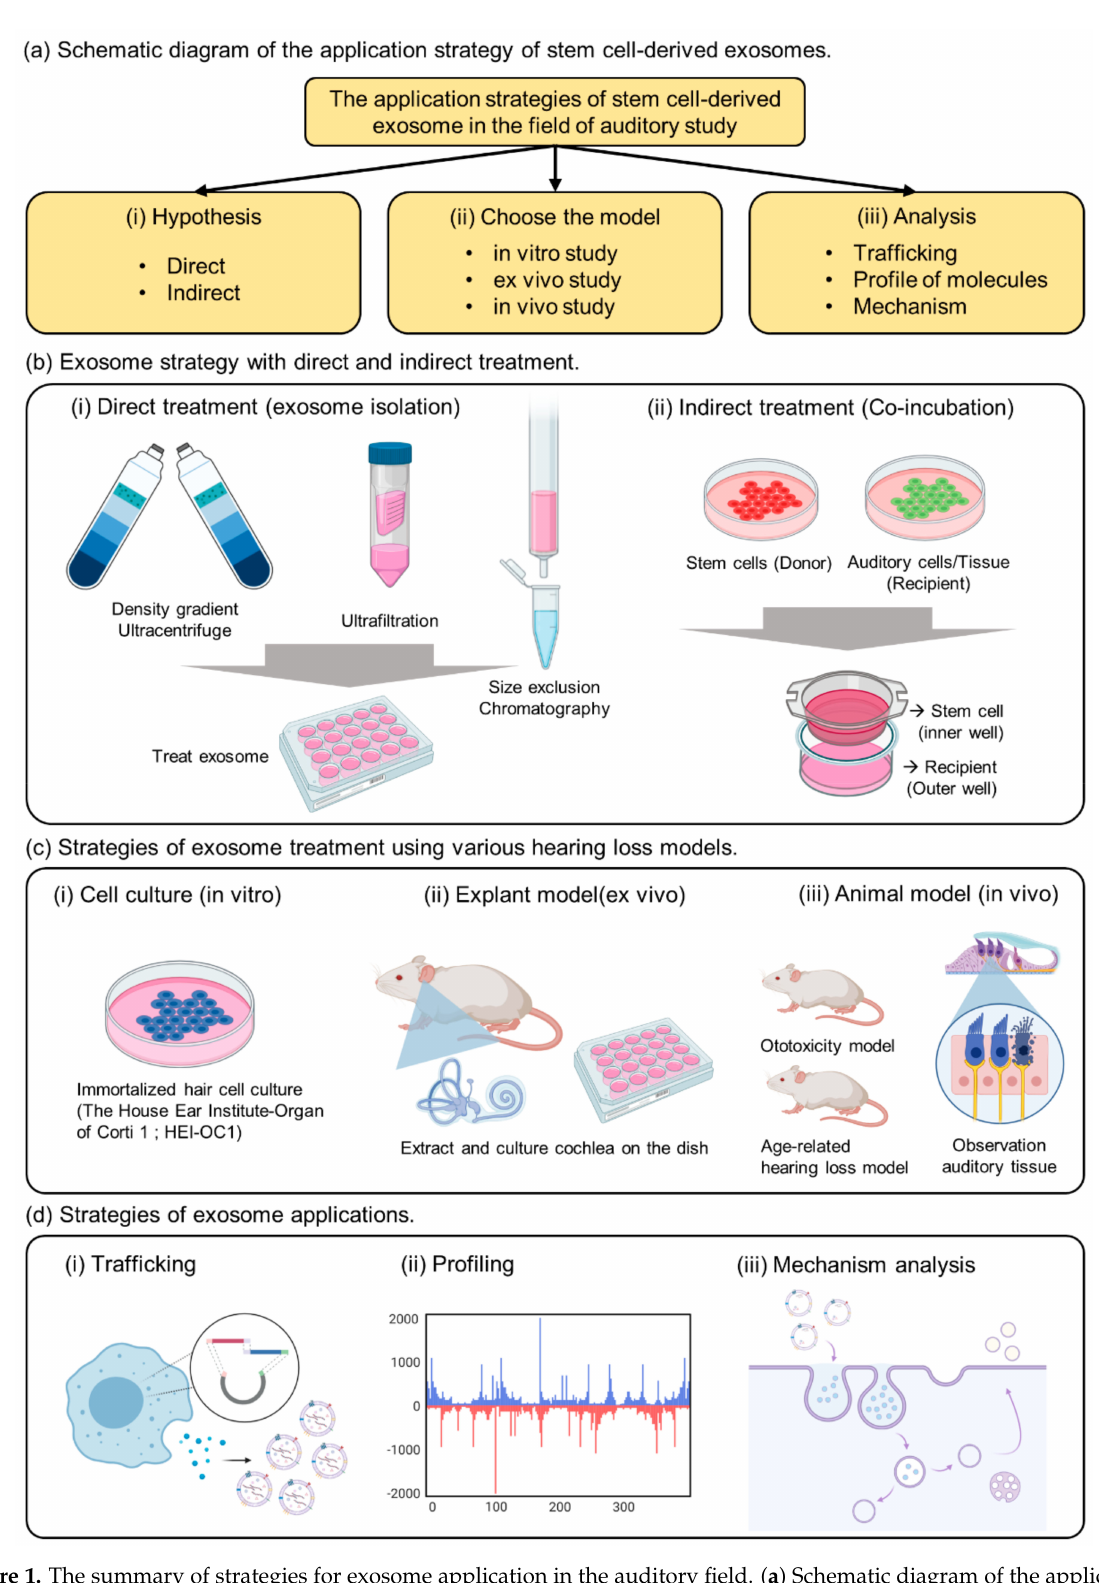
Figure 1. The summary of strategies for exosome application in the auditory field. ( a ) Schematic diagram of the application strategy of stem cell-derived exosomes. ( b ) Exosome strategy with direct and indirect treatment. ( c ) Strategies of exosome treatment using various hearing loss models. ( d ) Strategies of exosome